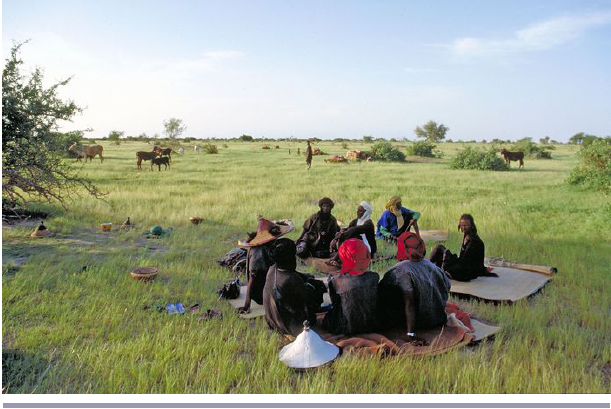
Fig. 1 . Wo ɗ aa ɓ e herders discussing their next move.